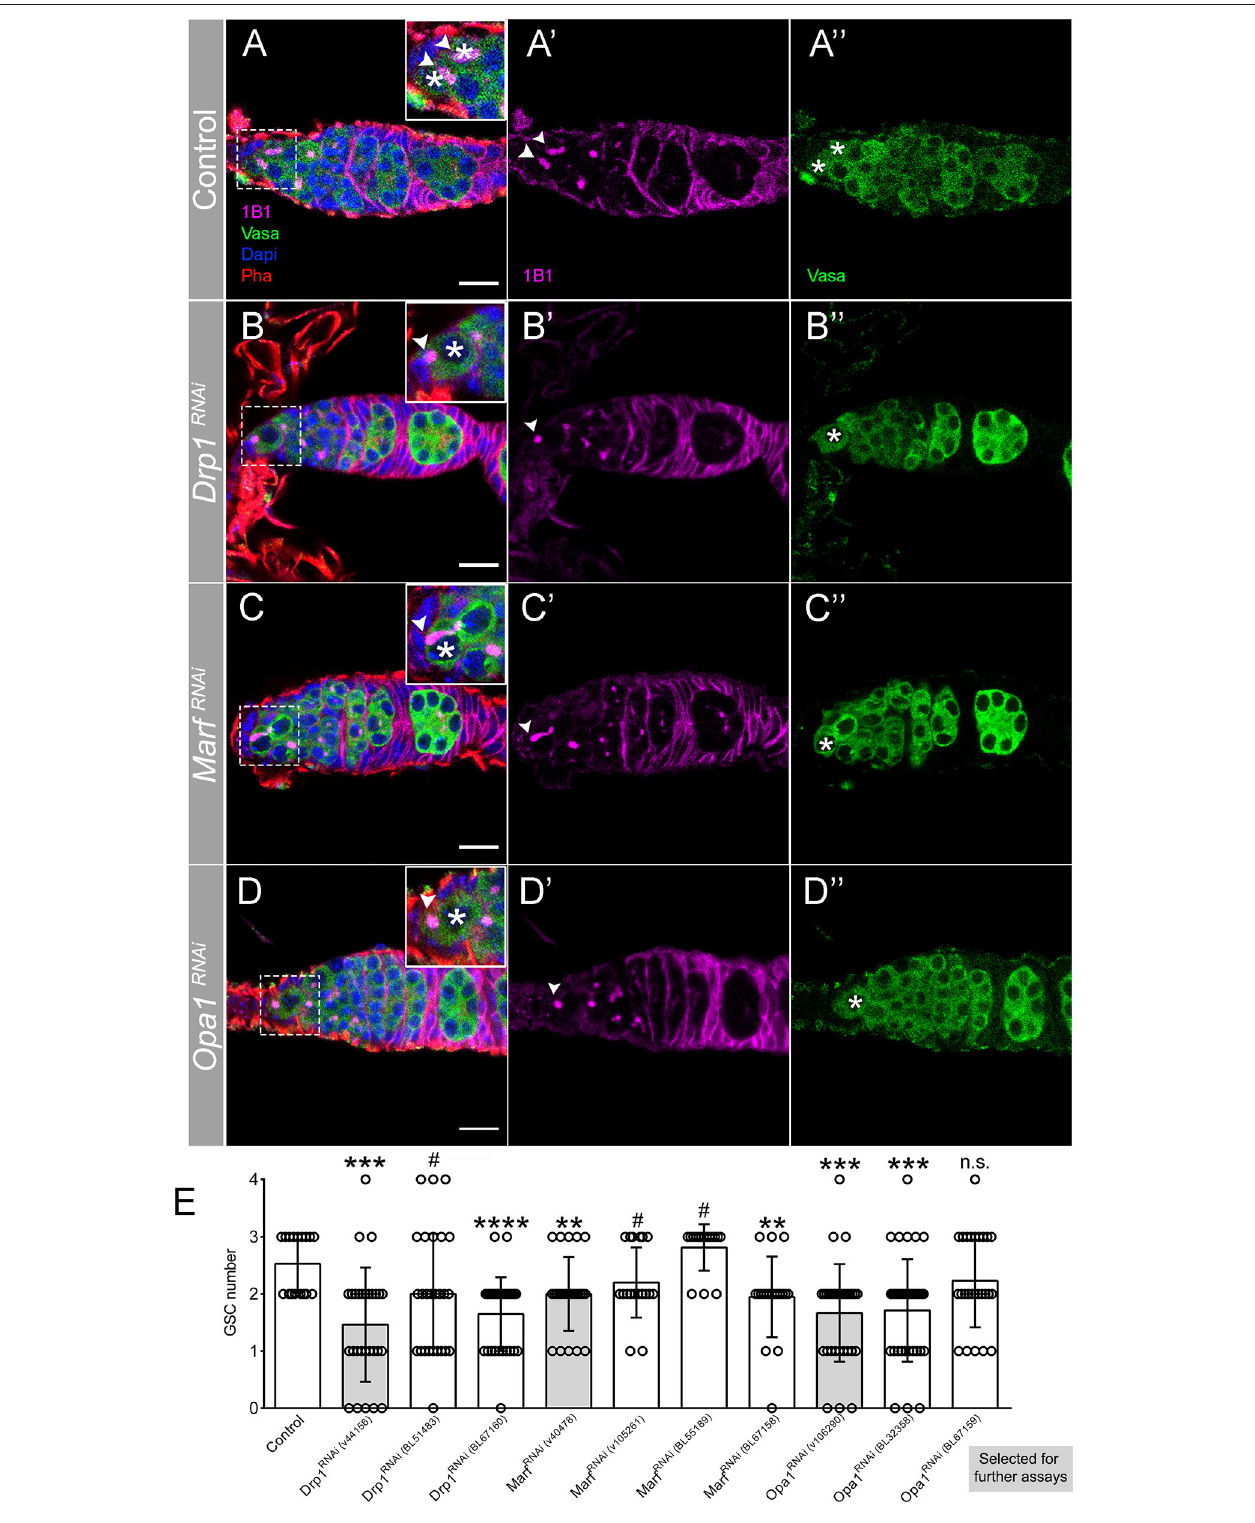
FIGURE 2 | Regulators of mitochondrial fission and fusion are essential for GSC maintenance. (A–D) Representative images of adult Drosophila germaria expressing RNAi transgenes against mCherry (control), Drp1 , Marf , and Opa1 by nos Gal4. Germ cells are labeled with Vasa antibody (green), and GSCs are marked by the